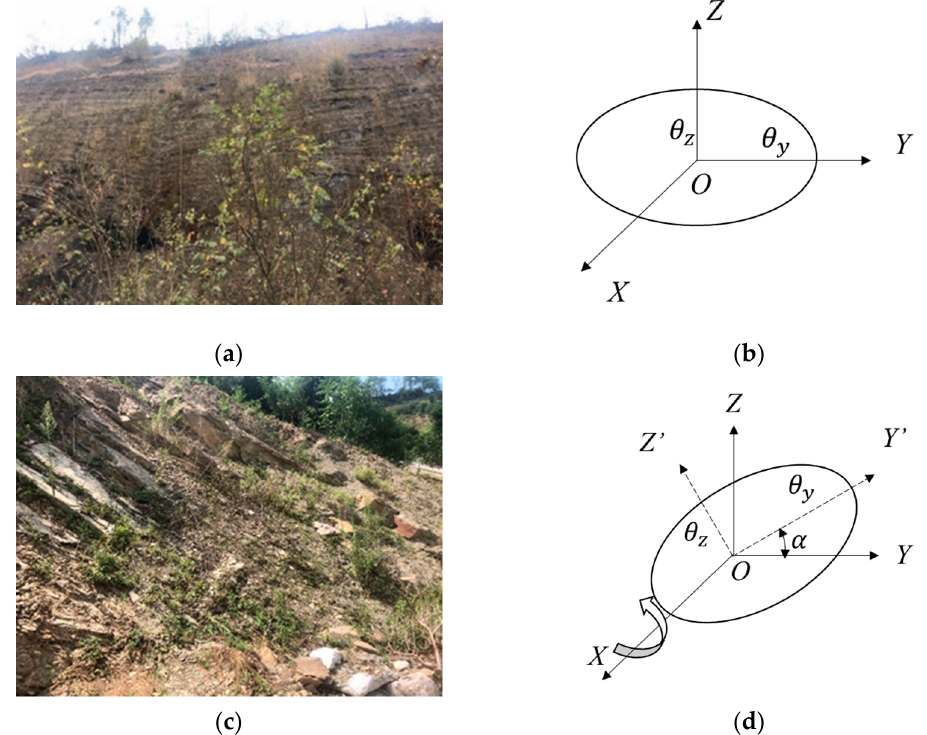
Figure 3. Correlation structure of different related structures. ( a ) Horizontal rock slope; ( b ) schematic diagram of the correlation length of the x = 0; ( c ) rotational anisotropic slope; ( d ) correlation length of rotational anisotropy after rotation of the α angle about the X